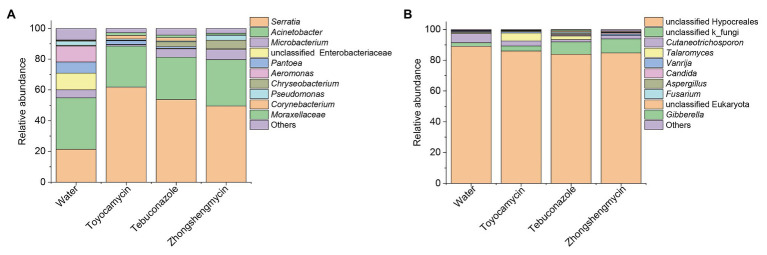
Relative abundances of top 10 bacteria (A) and fungi (B) with respect to relative abundance at the genus level in BPH. Each bar or column corresponds to a genus (three replications were high-throughput sequencing for each treatment). The value is the average of the relative abundance for the three replications calculated by SPSS 25.0 and the figures were drawn by Origin 8.5.